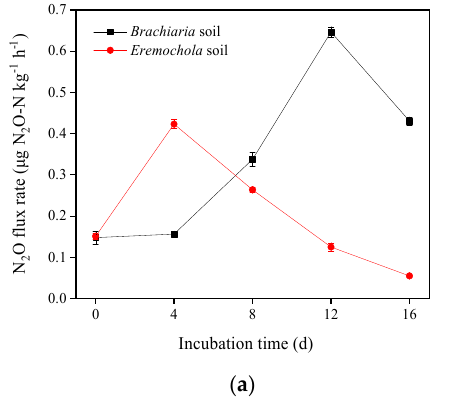
Figure 4. Fluxes ( a ) and cumulative emissions ( b ) of N 2 O in the Brachiaria and Eremochloa soil during the 16-day incubation. Different lowercase indicates denote a significant difference between treatments at p < 0.05. Vertical bars denote the standard deviation of the mean ( n = 3). Table 3. Average N 2 O production rates, the relative contribution of each nitrogen transformation process, and the ratio of N 2 O emissions from heterotrophic and autotrophic nitrification and denitrification in the Brachiaria and Eremochloa soils.